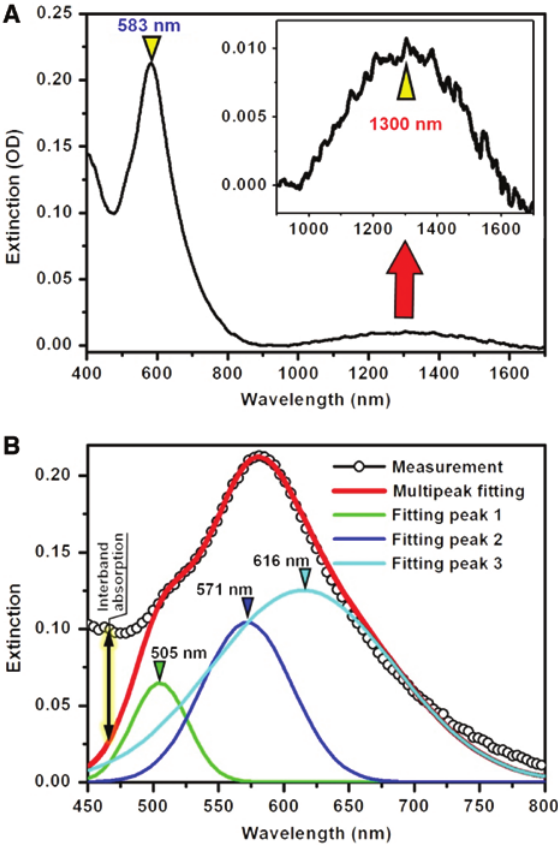
Figure 6: Spectroscopic characterization of the plasmonic grating. (A) Measurement of the transmissive optical extinction spectrum of the 2D gold gratings. Inset: enlarged view of the spectrum in the IR. (B) Multipeak fitting to the measurement data in the spectral range from 450 to 800 nm using Gaussian functions.